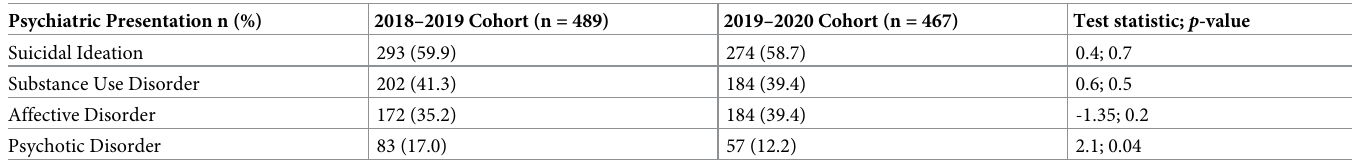
Table 2. Pre-period unadjusted comparison of psychiatric presentations. Psychiatric Presentation n